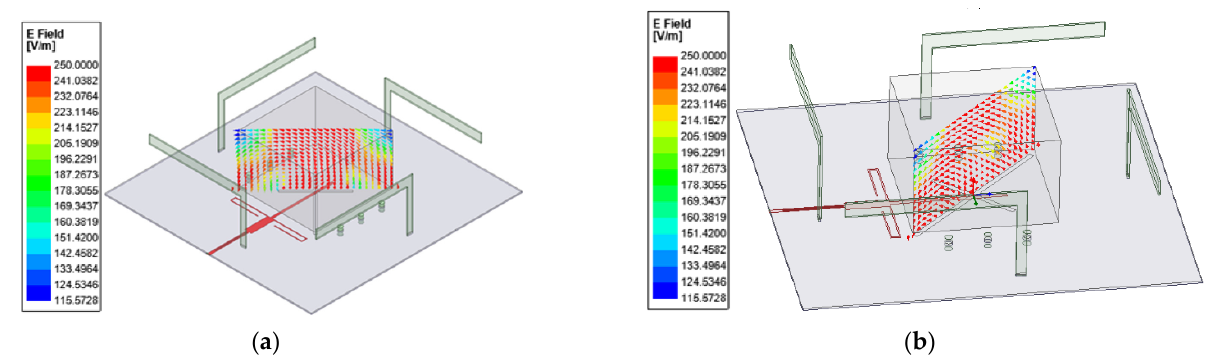
Figure 3. Simulate the E-field of proposed antenna. ( a ) y’oz at 1.47 GHz. ( b ) x’oz at 1.7 GHz. Figure 4a,b gives the simulated AR with a different length of short slot and the inverted L-shaped strip, respectively. As seen in the Figure 4a, the short slot has serious effects on the second AR minimum, but a slight effect on the first AR minimum and no effect on the third AR minimum. This is because the length of the short slot has little influence on the TE y’ mode, thus having a slight effect on the first AR minimum. The third AR minimum is introduced by the rotationally symmetric inverted L-metals, so the length of the short slot has no effect on the third AR minima. Figure 4b shows that when the length of the inverted L-shaped metal increases, the frequencies of the third AR minimum gradually decreases, while the other two AR minima are hardly affected.